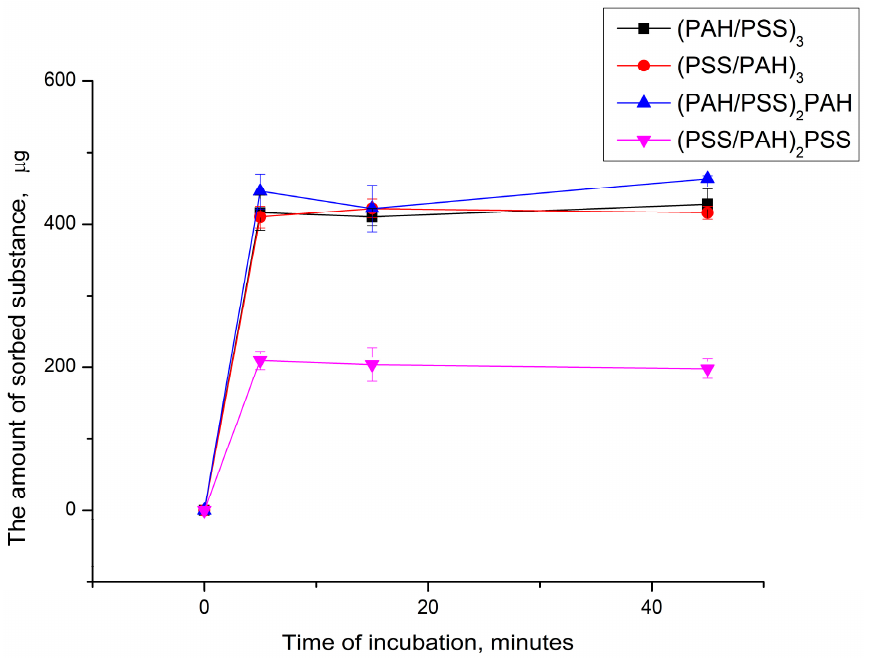
Figure 5. Change in the amount of sorbed potassium ferricyanide by PMC depending on the time of incubation.